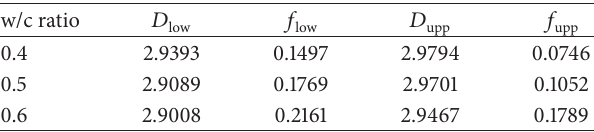
Figure 6: Parametric analysis of cement pastes with varying w/c ratios. Table 1: Fractal dimensions and the associated porosities.